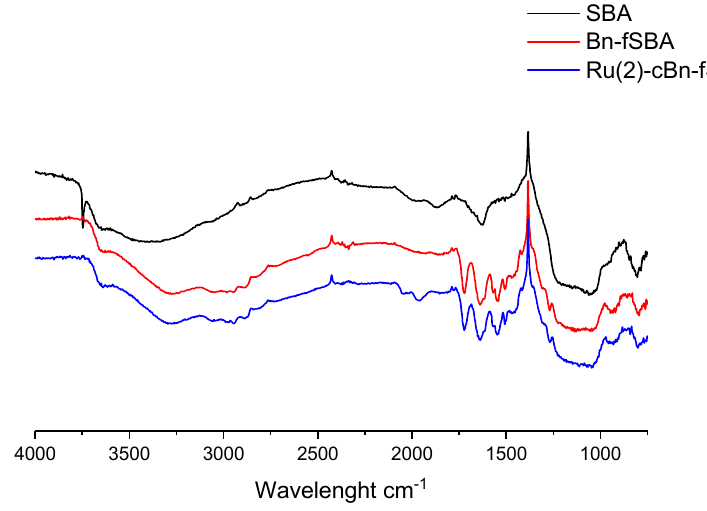
Figure 4. IR spectra of native SBA and its functionalization products.